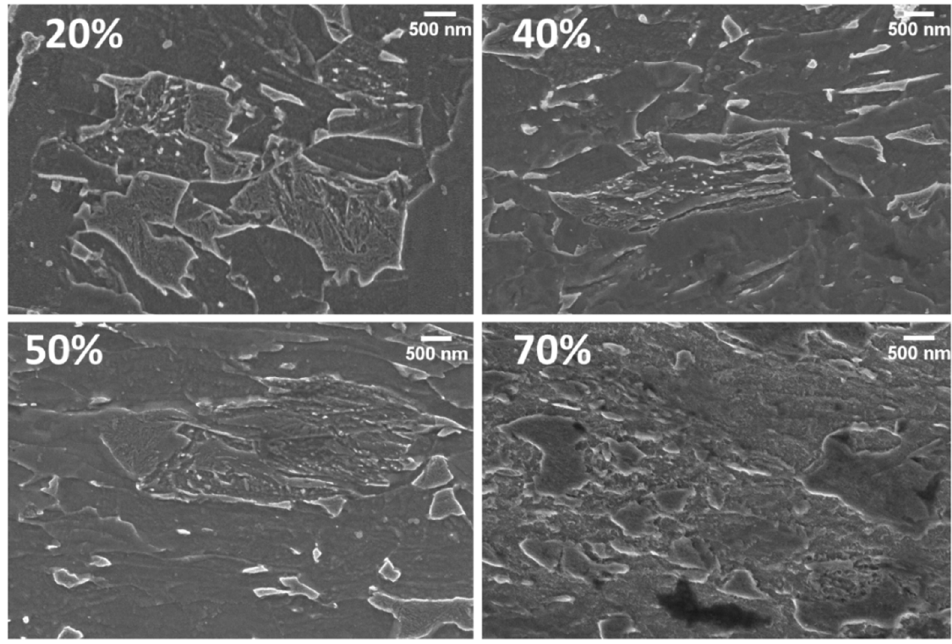
Figure 6. Bainite fragmentation: carbides appear more homogenously distributed as the strain hardening level is increased.